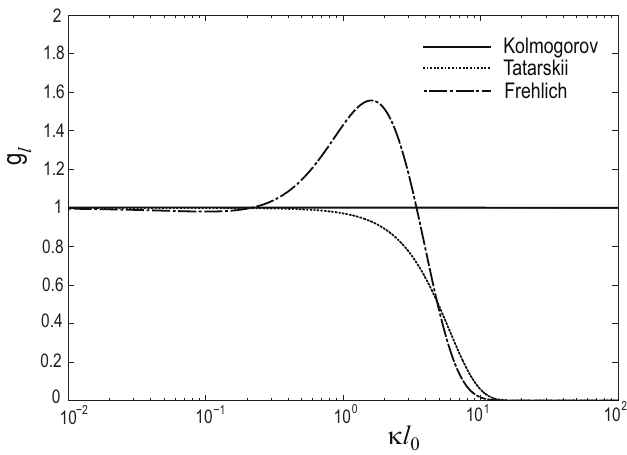
Figure 7. Function g l depending on κ l 0